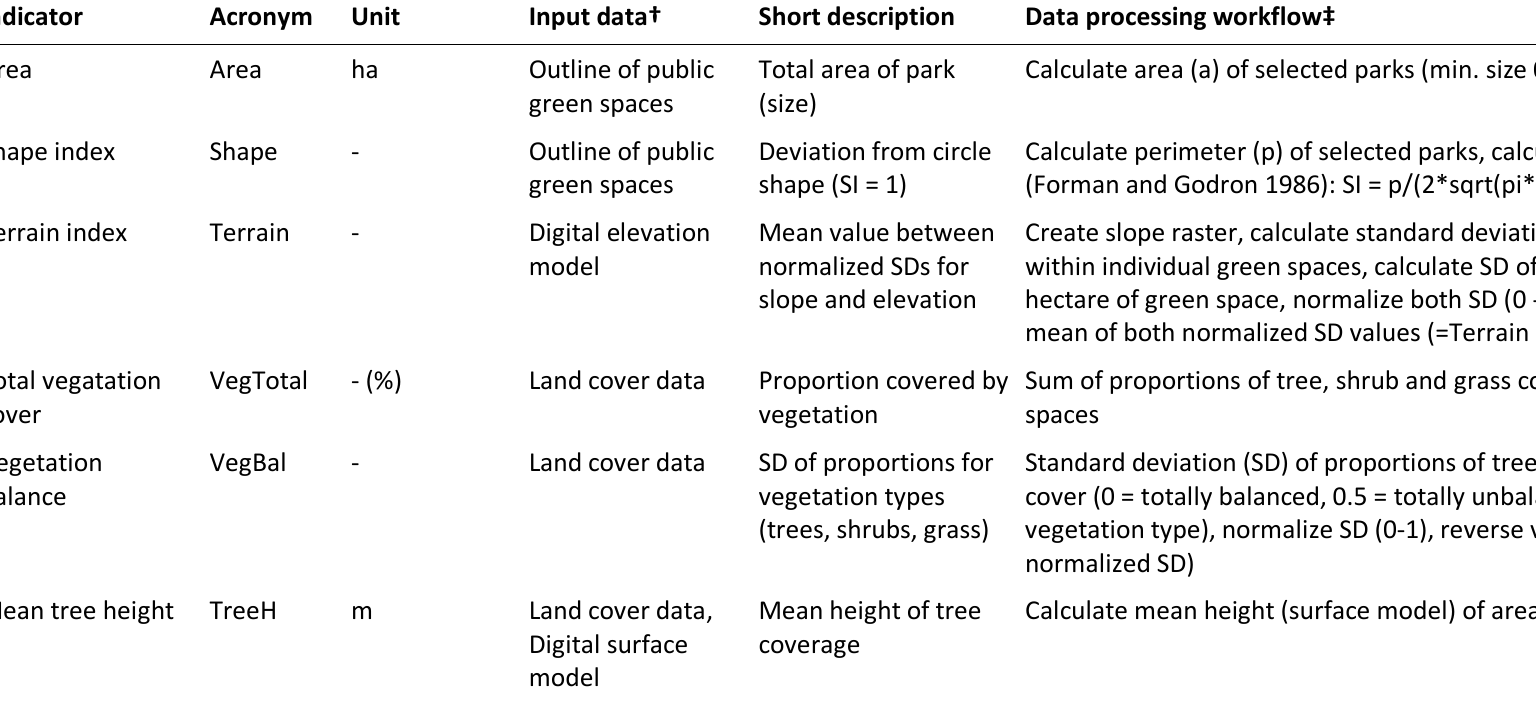
Table A1.2. Details on green space indicators. Acronyms used: SD = standard